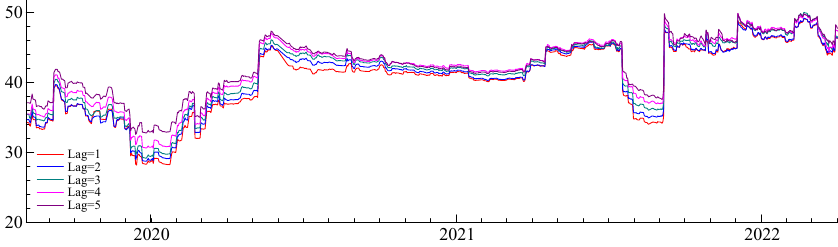
Fig. 37 Dynamic total RS connectedness with different VAR lags